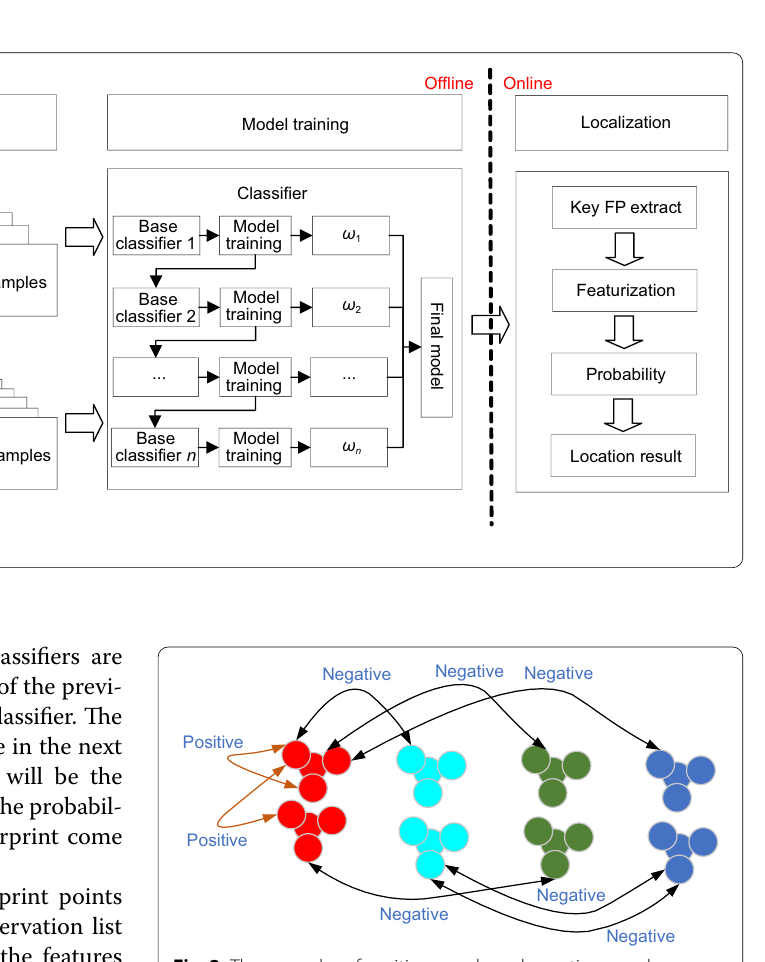
Fig. 2 The examples of positive sample and negative